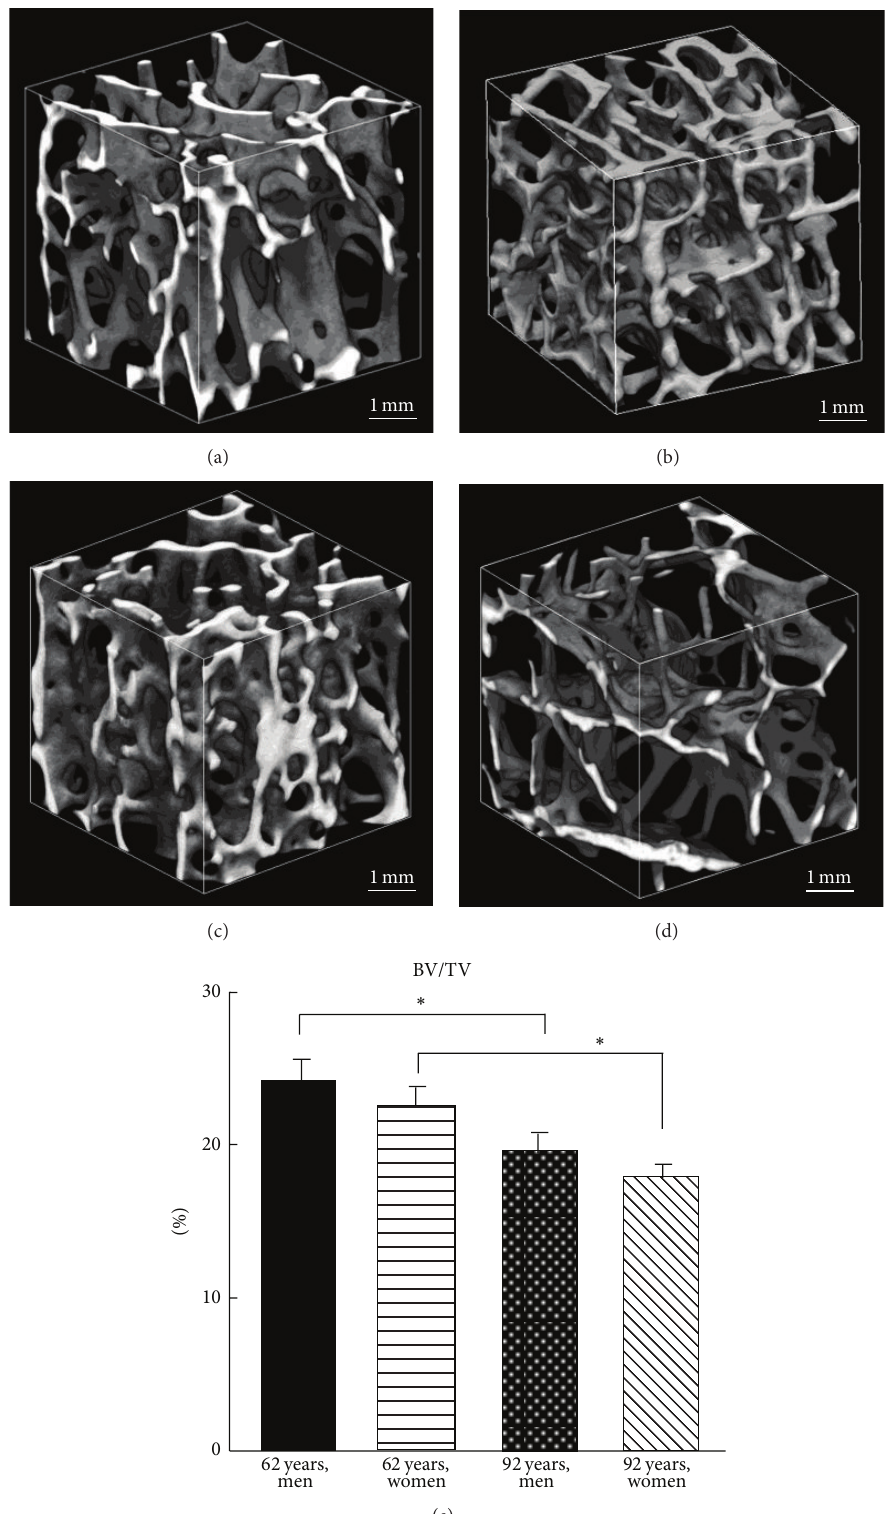
Figure 3: 3D reconstructed images of trabecular microstructure at the proximal tibia from a man aged 62 years (a), a man aged 92 years (b), a woman aged 62 years (c), a woman aged 92 years (d), and the corresponding values for BV/TV (e). The trabecular bone volume fraction is highest in man aged 62 years and lowest in woman aged 92 years ( ∗ 𝑃 < 0.05 )